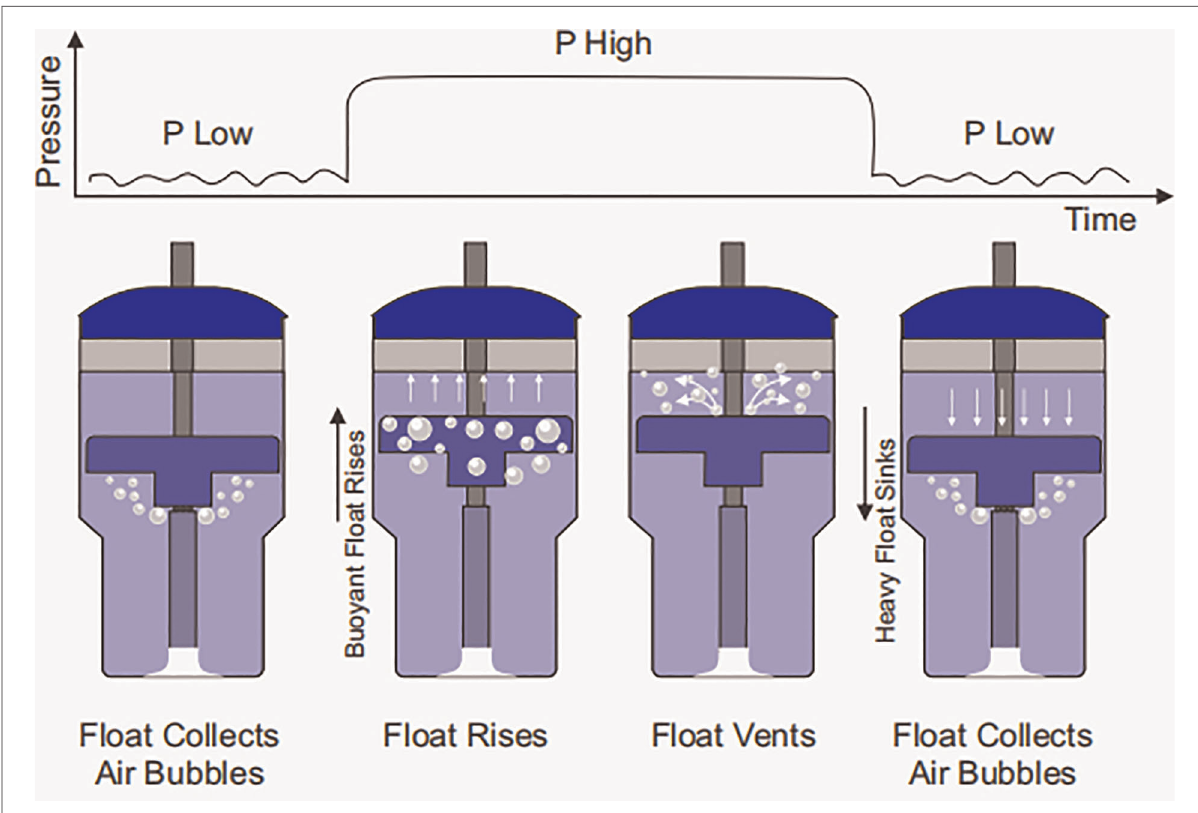
FIGURE 2 the NeoVent Bubble-NIPPV device. Figure used with permission from AIM